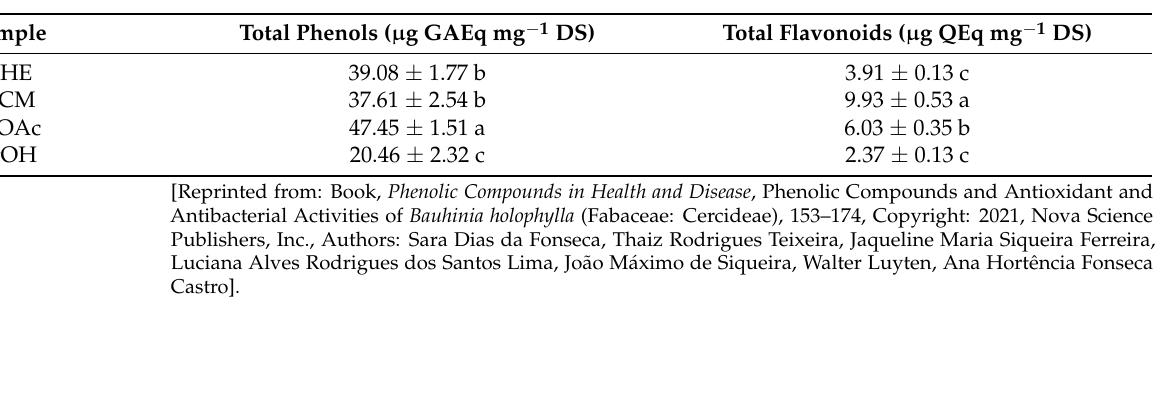
Table 1. Total phenol and flavonoid contents in the extract and fractions of B. holophylla leaves. CHE: crude hydroethanolic extract; DCM: dichloromethane fraction; EtOAc: ethyl acetate fraction; EtOH: hydroethanolic fraction. The results were compared using Tukey’s test, and they are presented as the mean ± standard deviation of three repetitions. Means with the same letter do not differ statistically from each other (p -value <